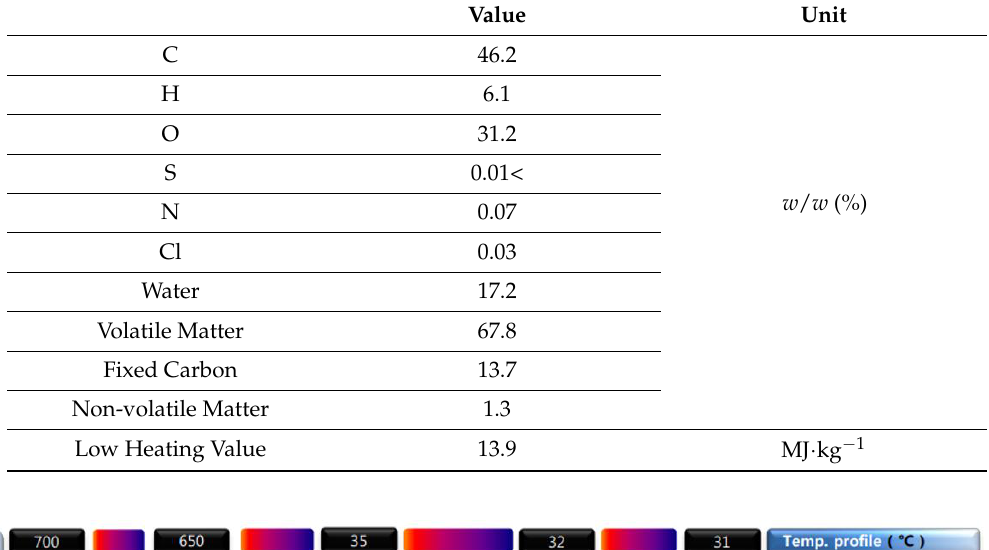
Table 5. Characteristics of the raw materials (wood chips) used to produce syngas.